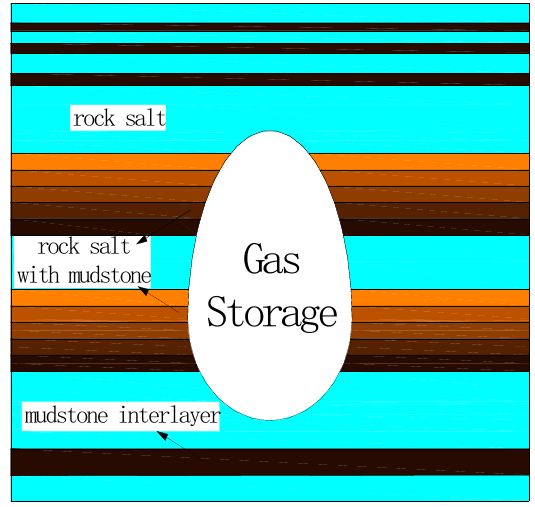
Figure 1. Schematic diagram of a salt cavern gas storage facility.